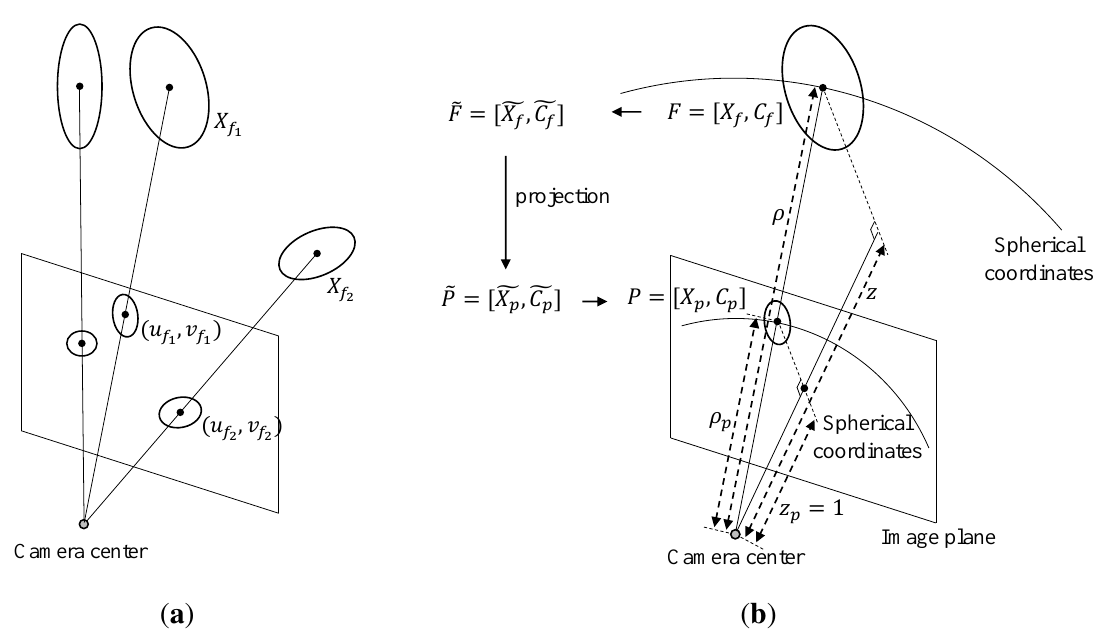
Figure 2. ( a ) The projection results of probabilistic features on the map; ( b ) The projection of the probabilistic feature on the map onto the image plane using spherical